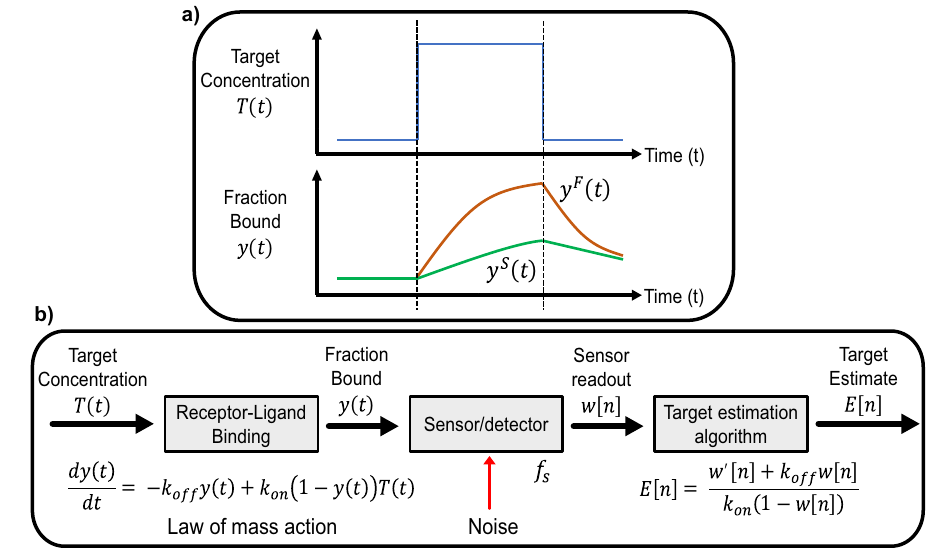
Fig. 2 | Pre-equilibrium sensing. a In a short time interval, a molecular receptor withfastkineticswillaccumulatemoresignal, y F ð t Þ ,inresponsetoarapidchangein target concentration, T ( t ), than one with slow binding kinetics, y S ð t Þ . b Anupdated